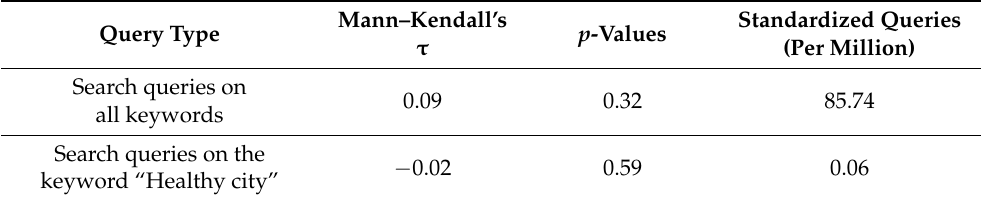
Table 4. Mann–Kendall test results of the times series of the search queries.